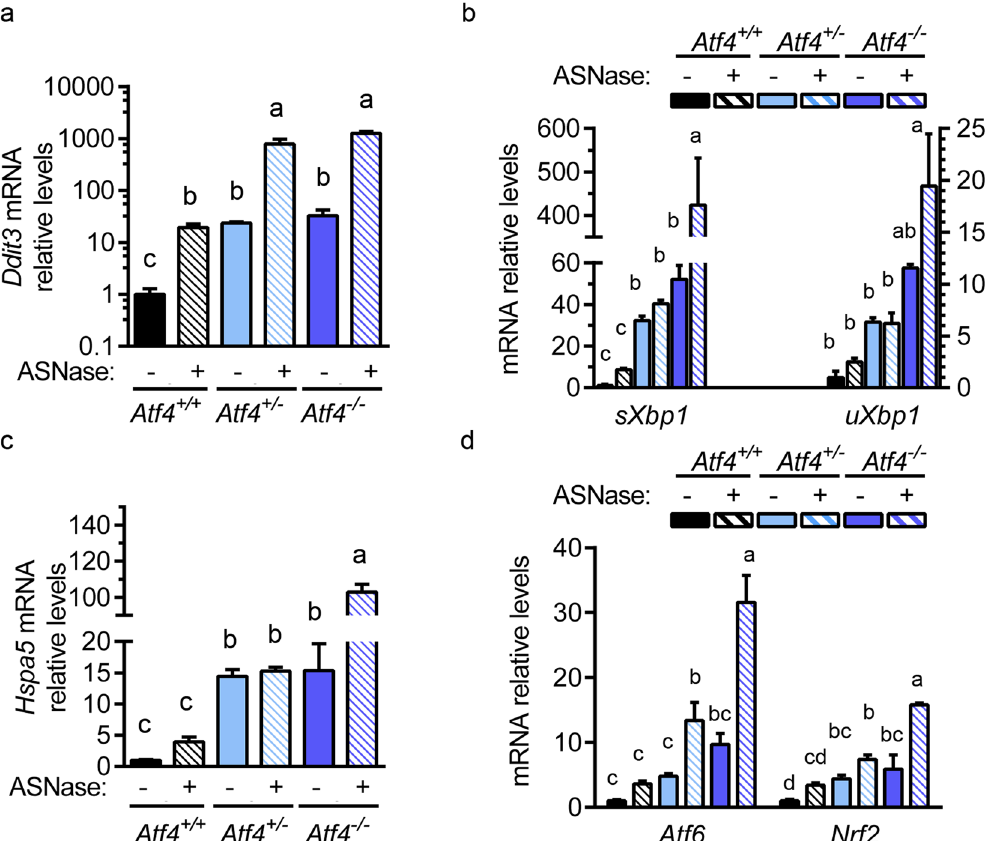
Figure 7. Atf4 haploinsufficiency predisposes mice to amplified ER stress when treated with 8 daily injections of asparaginase (3 IU per gram body weight, ASNase). Gene expression levels of: ( a ) Ddit3 (CHOP), ( b ) spliced Xbp1 and unspliced Xbp1 , ( c ) Hspa5 (BiP/Grp78), and ( d ) Atf6 and oxidative stress marker Nrf2 were measured in liver by RT-qPCR. Data are represented as the average value ± standard error of the mean, n = 4–6 per group. Means without a common letter are different according to Tukey post hoc analysis following ANOVA, P <